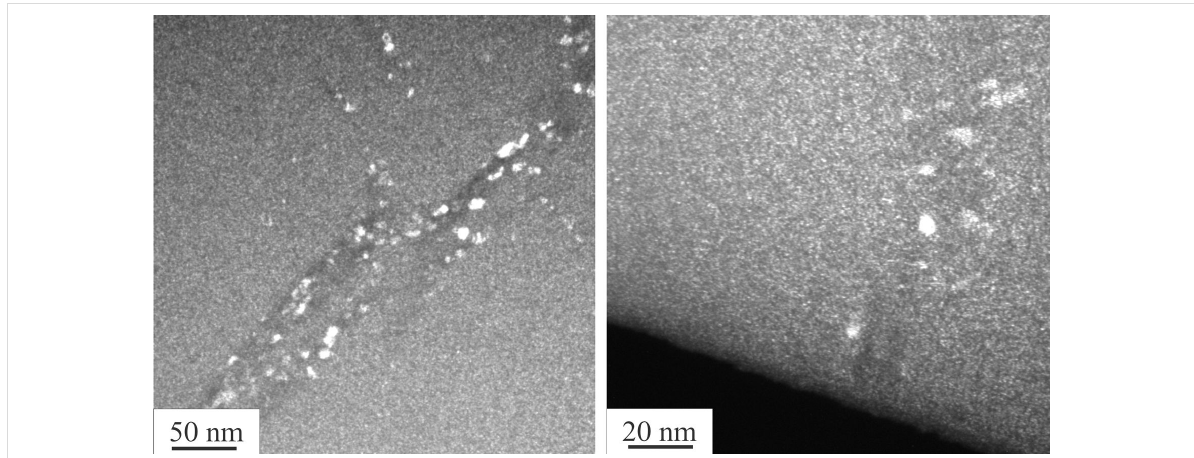
Figure 2: Dark field TEM analysis of cold-rolled (left) and cold-rolled and annealed samples. The sample was annealed at 60 °C for 10 days (right).